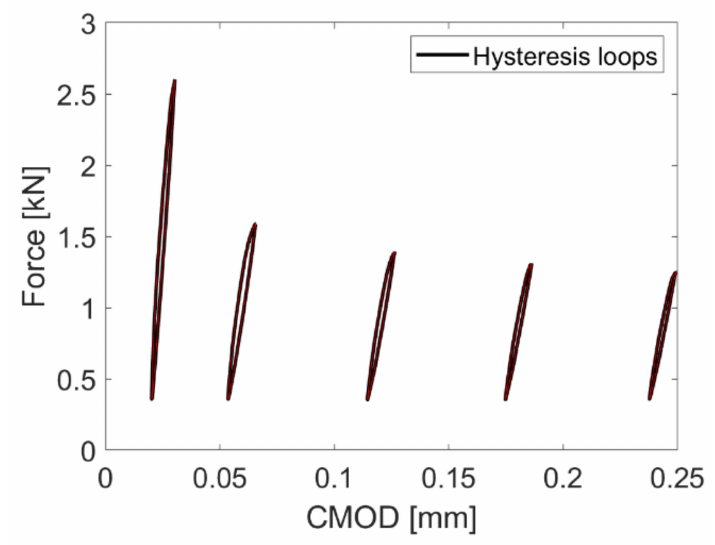
Figure 16. Extracted first five hysteresis loops due to unloading-reloading cycles in the Exp.